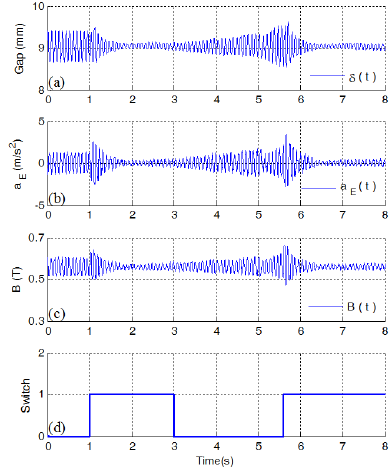
Figure 13. The experimental verification for vibration suppression method, which is activated during [1 3] and [5.5 8]: ( a ) the levitation gap; ( b ) the acceleration of electromagnet; ( c ) the magnetic flux; and ( d ) the switch